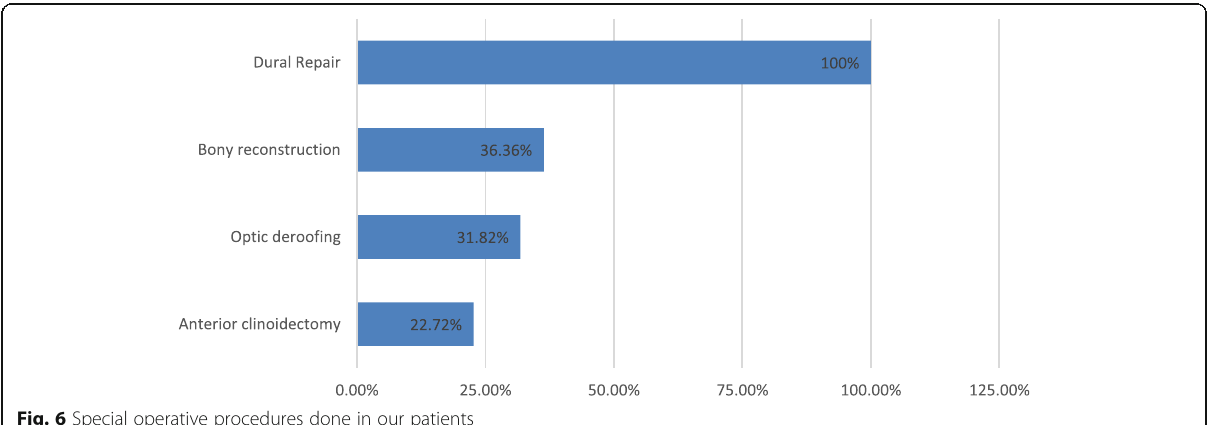
Fig. 6 Special operative procedures done in our patients